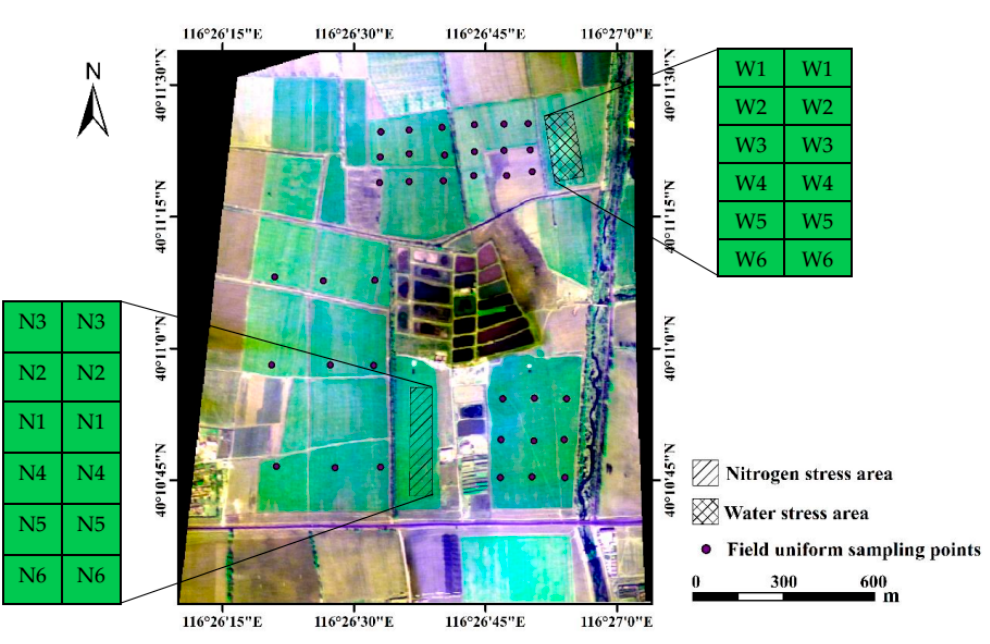
Figure 1. Study area and distribution of sampling points. The background is the true color of the OMIS image (477 nm for blue, 553 nm for green, and 638 nm for red). The six levels of nitrogen stress application were as follows: N1, 0 kg/ha, N2, 75 kg/ha, N3, 150 kg/ ha, N4 225 kg/ha, N5, 300 kg/ha, and N6, 375 kg/ha. The six levels of water stress application were as follows: W1, 0 m 3 /ha, W2, 225 m 3 /ha, W3, 500 m 3 /ha, W4, 725 m 3 /ha, W5, 1000 m 3 /ha, and W6, 1125 m 3